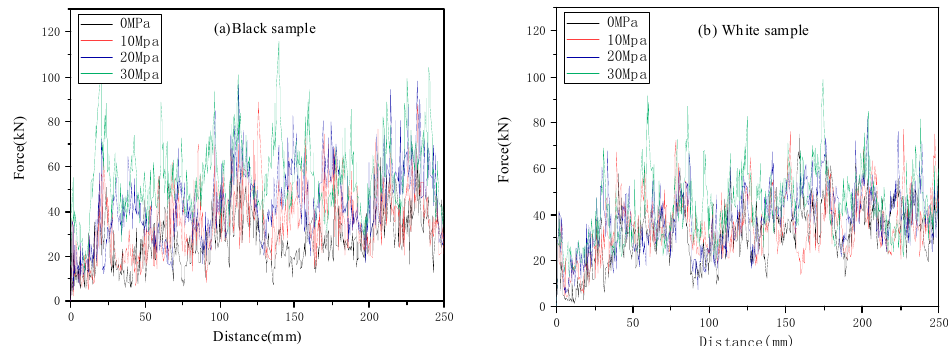
Figure 14. Variation of ratio of tensile crack to shear crack.